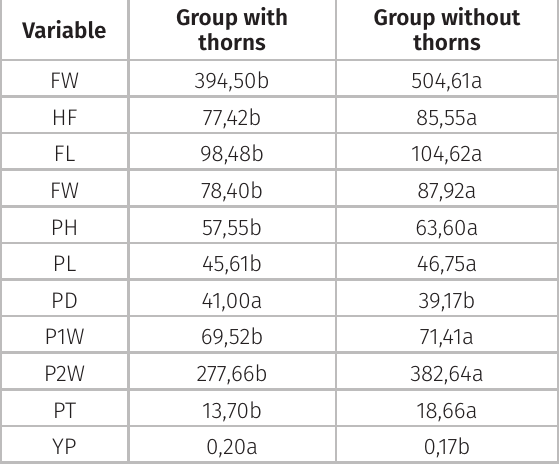
Table I. Mean values for the eleven variables measured in fruits of Caryocar brasiliense with and without thorns in the endocarp, cultivated at Água Limpa Experimental Station - UFU, Uberlândia, MG,